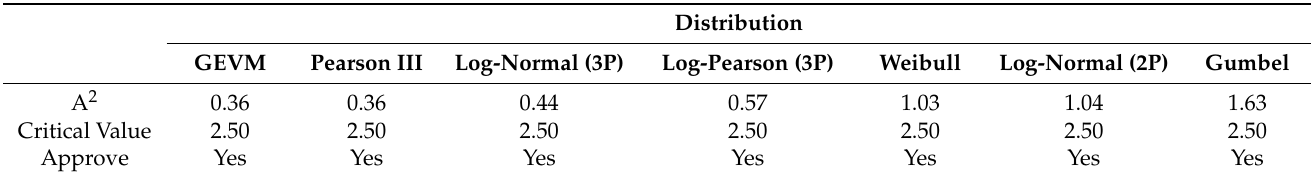
Table 3. Indicators of fit provided by the Anderson–Darling test.